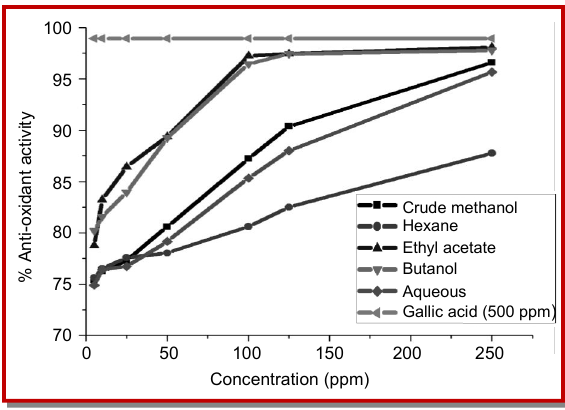
Figure 1: Anti-oxidant potential of crude methanol, hexane, ethyl acetate, butanol and water extracted samples from leaves of Calamus aromaticus in DPPH radical scavenging